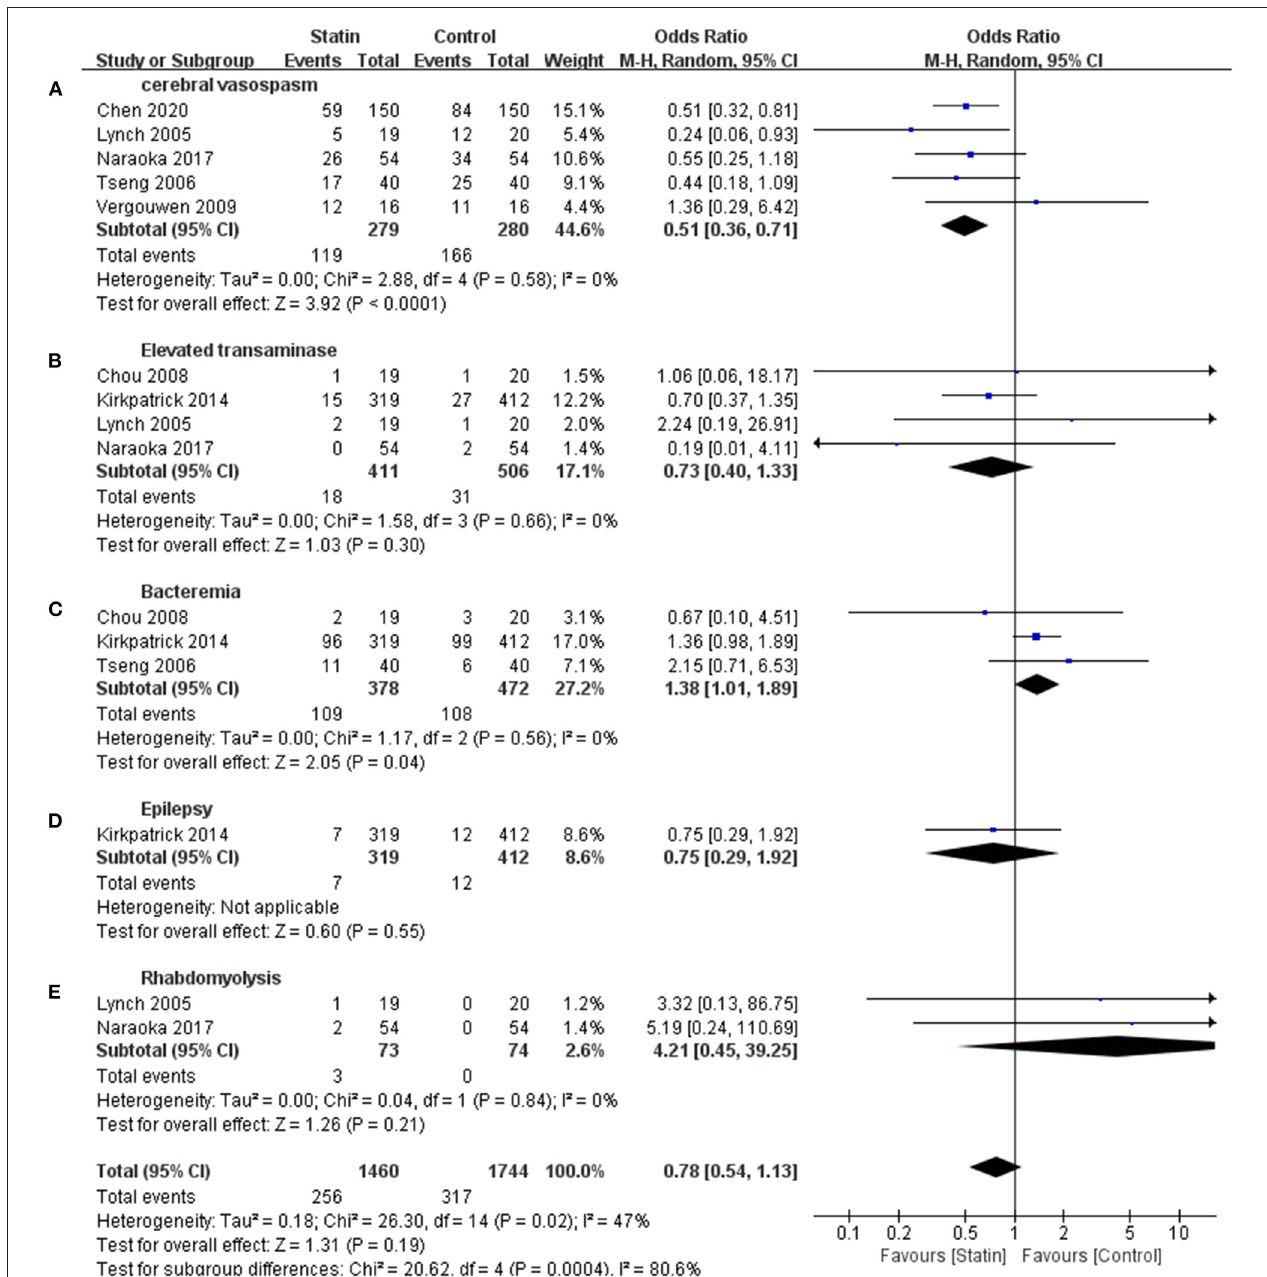
FIGURE 3 | Meta-analysis of complications for statin vs. placebo. (A) Lower cerebral vasospasm rate in statin group was demonstrated. (C) Increased bacteremia was shown in statin group. (B,D,E) Complications events including elevated transaminase, rhabdomyolysis, and epilepsy were similar in both